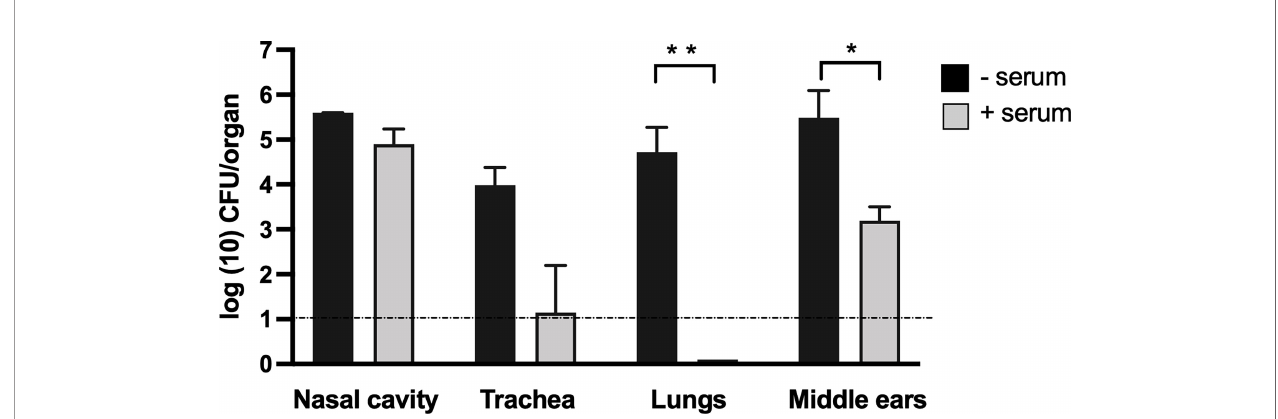
FIGURE 4 | Adoptively transferred convalescent serum protects the lower respiratory tract but is less effective in the nasal cavity and middle ears. Graphs represent the number of CFUs recovered on 3 dpi from the nasal cavity (NC), trachea (TR), lungs (LNG), and middle ears (ME) of groups of C57Bl/6J mice. The adoptively